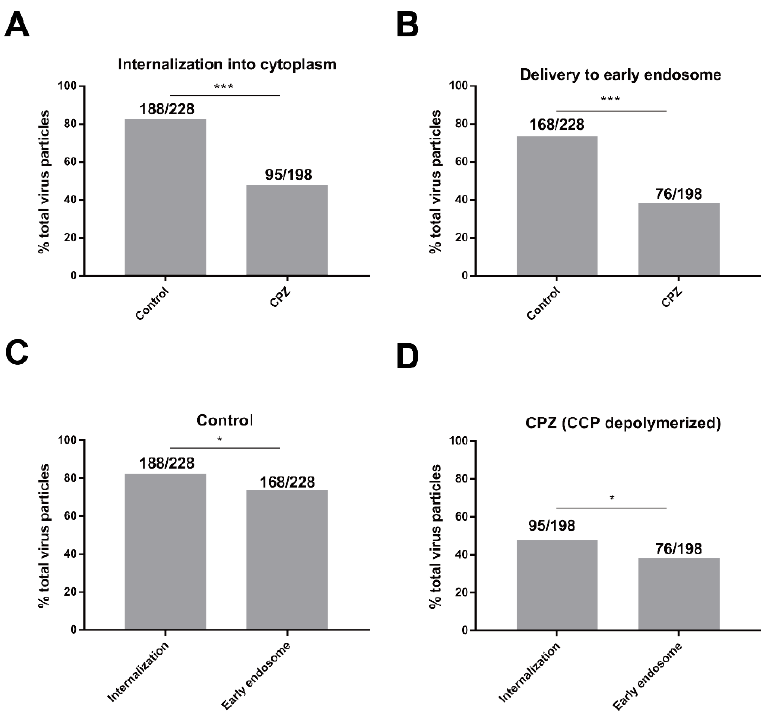
Figure 4. AcMNPV enters cells via an early endosome-independent pathway. ( A ) Quantification of the percentage of AcMNPV internalization into the cytoplasm in the absence or presence of CPZ. The percentage of virus particle internalization over total virus particles in control cells was represented by 188/228. The percentage of virus particle internalization over total virus particles in CPZ-treated cells was represented by 95/198. Individual virus particles were observed for 10 min upon binding to the cell surface (*** indicates p < 0.001, Pearson χ 2 test). ( B ) Quantification of the percentage of AcMNPV delivery into early endosomes in the absence or presence of CPZ. The percentage of virus particle delivery to early endosome over total virus particles in control cells was represented by 168/228. The percentage of virus particle delivery to early endosome over total virus particles in CPZ-treated cells was represented by 76/198l. Virus particles that colocalized with the early endosomes for more than 1 min were defined as efficient delivery to early endosomes (*** indicates p < 0.001, Pearson χ 2 test). ( C , D ) Quantification of the percentage of AcMNPV internalization into the cytoplasm and delivery to early endosomes in control cells ( C ) and CPZ-treated cells ( D ) The percentage of virus particle internalization over total virus particles in control cells was represented by 188/228. The percentage of virus particle delivery to early endosome over total virus particles in control cells was represented by 168/228. The percentage of virus particle internalization over total virus particles in CPZ-treated cells was represented by 95/198. The percentage of virus particle delivery to early endosome over total virus particles in CPZ-treated cells was represented by 76/198. (* indicates p < 0.05, Pearson χ 2